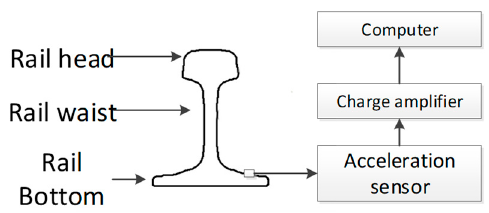
Figure 9. Composition of test System.